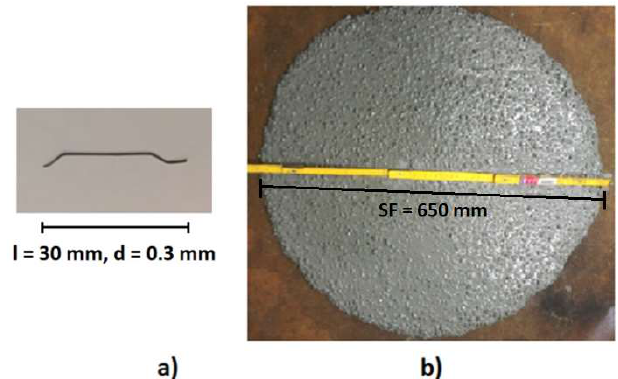
Figure 1. Steel reinforcement ( a ) and the slump flow test for the concrete mixture ( b